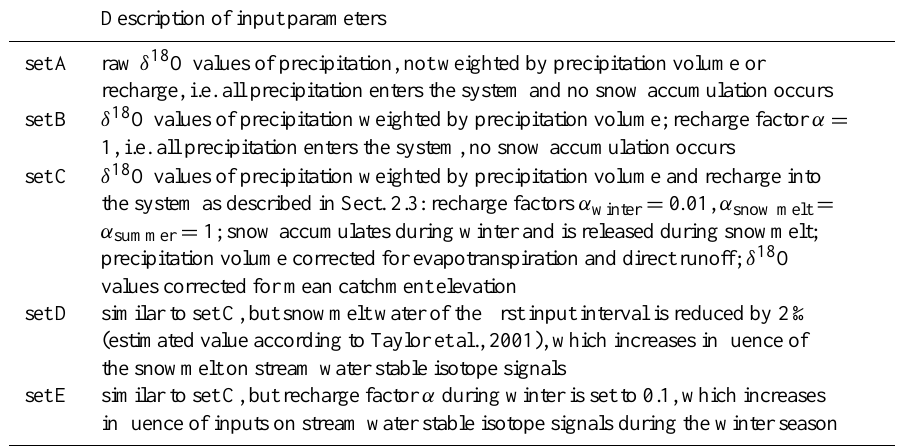
Table 2. Description of the different model input parameter sets. Description of input parameters set A raw δ 18 O values of precipitation, not weighted by precipitation volume or recharge, i.e. all precipitation enters the system and no snow accumulation occurs set B set C the system as described in Sect. 2.3: recharge factors α winter = 0 . 01, α snow melt = α summer = 1; snow accumulates during winter and is released during snowmelt; precipitation volume corrected for evapotranspiration and direct runoff; δ 18 O values corrected for mean catchment elevation set D (estimated value according to Taylor et al., 2001), which increases influence